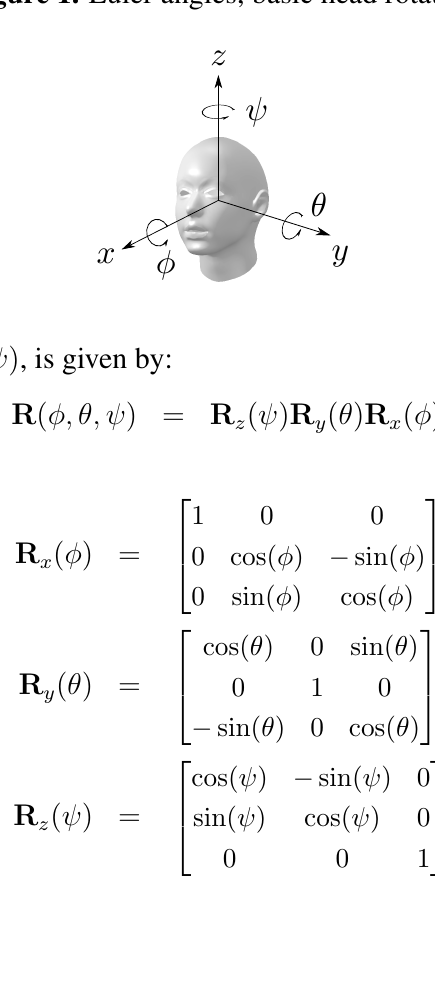
Figure 1. Euler angles, basic head